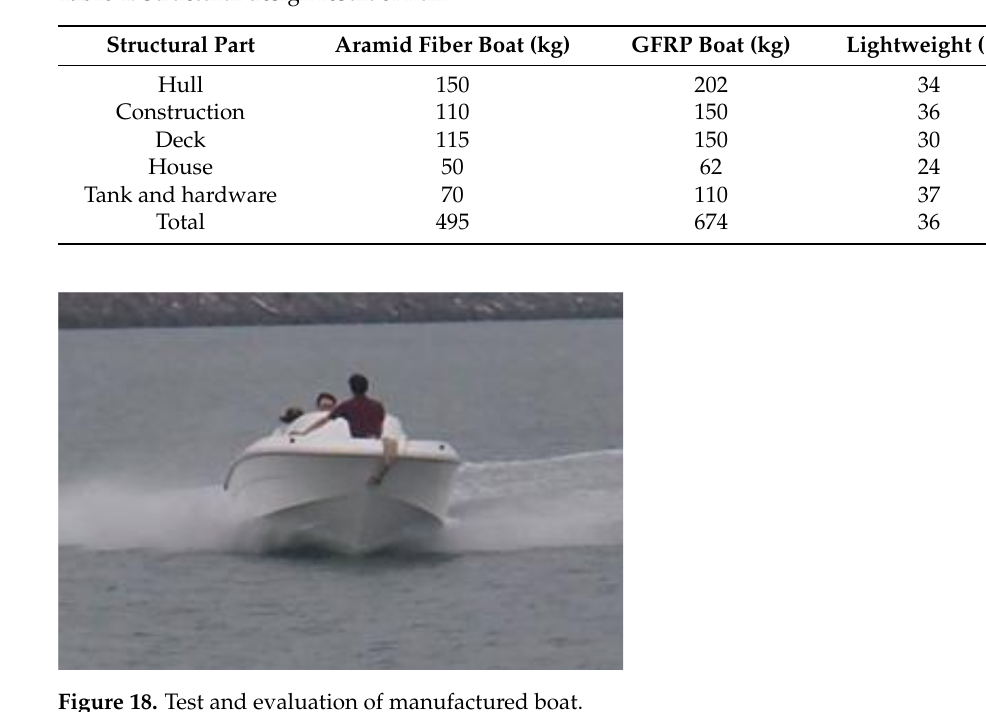
Table 4. Structural design result of hull.